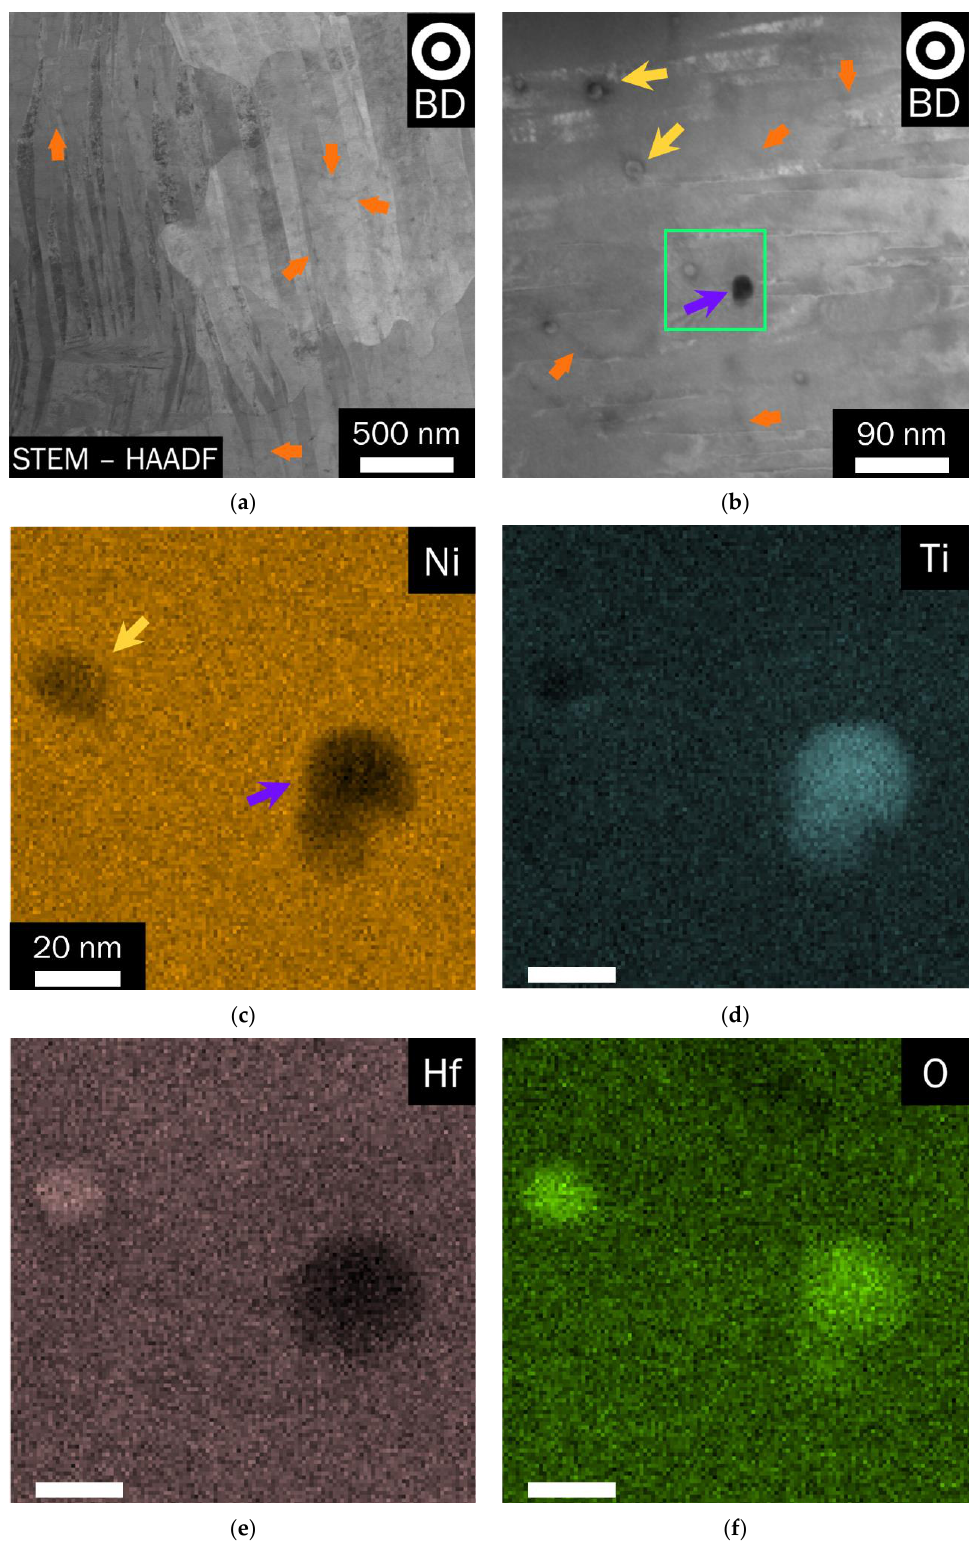
Figure 5. ( a , b ) Low-camera-length STEM image of A8 showing light z-contrast along the boundaries and ( c – f ) compositional analysis of the cellular solidification. Yellow and orange arrows show dark and light secondary phases, respectively. EDS analysis on the green area showed oxide formation on grain